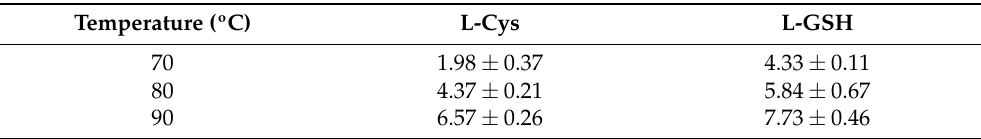
Table 1. Pseudo-first-order rate constants (10 − 4 s − 1 ) for the reactions of 6.4 × 10 − 4 M L-Cys and L-GSH with 1.054 × 10 − 4 M ACR at different